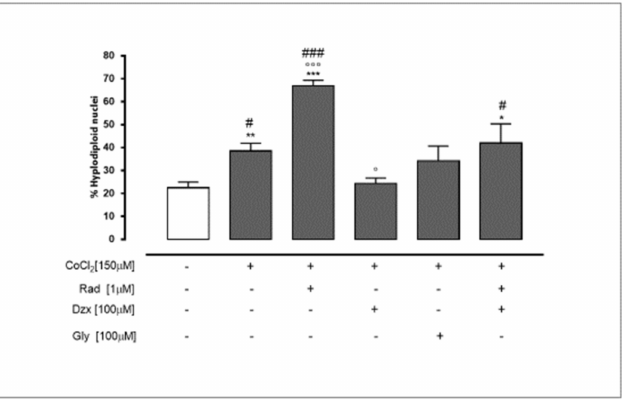
Figure 5. Mitochondrial Cx43 and the opening of mitochondrial K ATP channels counteract CoCl 2 - induced apoptotic response. Cells were treated for 3 h with CoCl 2 (150 µ M); rad (1 µ M), dzx (100 µ M) and gly (100 µ M) were added 30 min before CoCl 2 administration. H9c2 were stained by propidium iodide and fluorescence of individual nuclei was measured by flow cytometry. Results are expressed as mean ± S.E.M. of percentage of hypodiploid nuclei from at least three independent experiments, each performed in duplicate. Data were analysed by one way ANOVA and multiple comparisons were made by Bonferroni post-test. * p < 0.05, ** p < 0.005 and *** p < 0.001 vs. untreated cells; ◦ p < 0.05 and ◦◦◦ p < 0.001 CoCl 2 -treated cell; # p < 0.05 and ### p < 0.001 vs. CoCl 2 and dzx co-treated